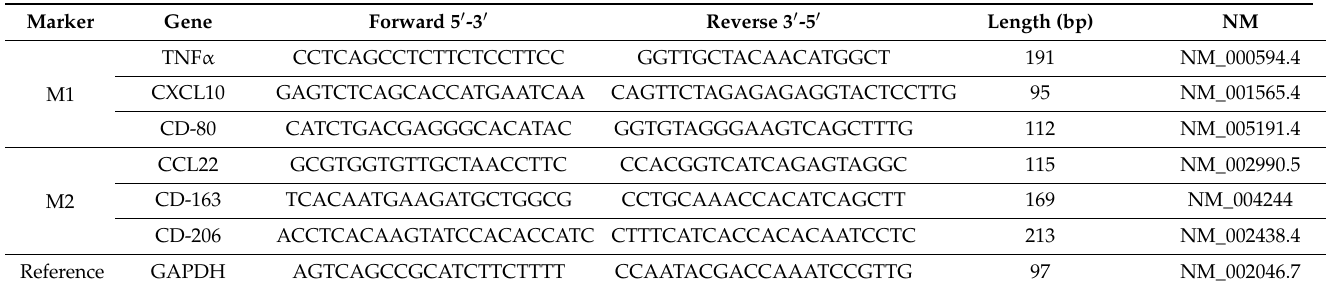
Table 1. qPCR primers designed on Primer-BLAST and verified on BLAST-N